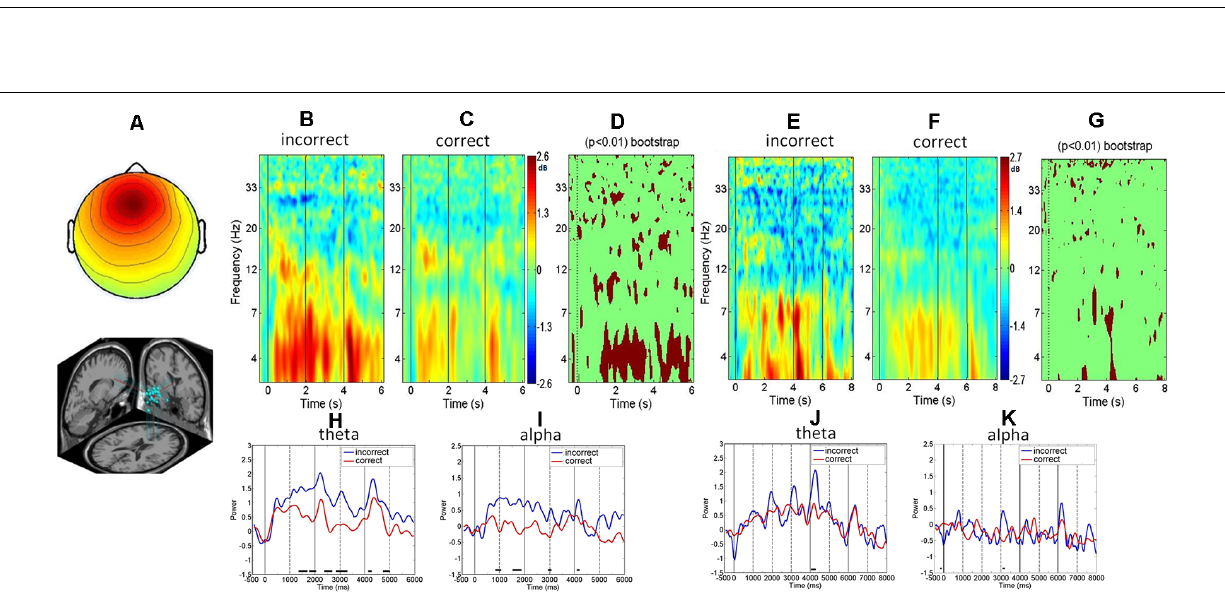
Frontiers in Human Neuroscience |